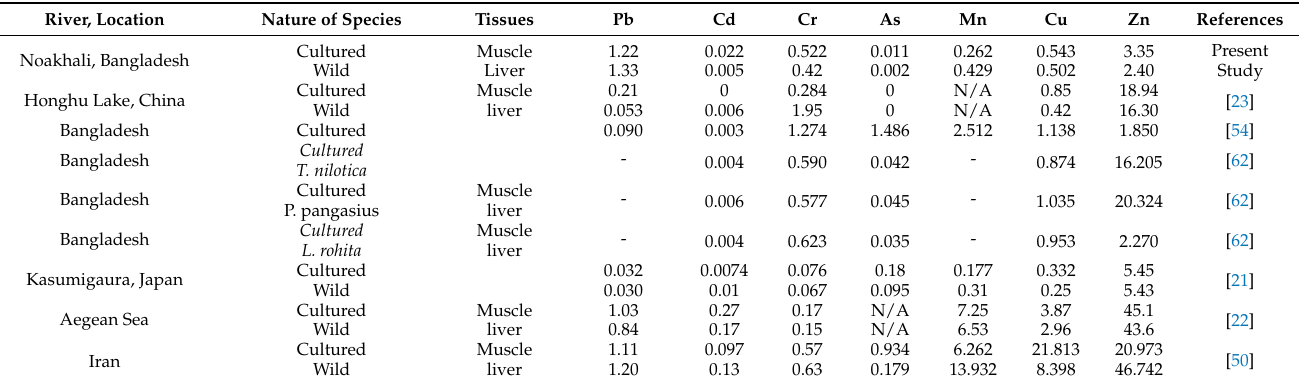
Table 3. Concentration of the metals (mg/kg wet weight) in the fish sample muscles of cultured and wild Barramundi in different global studies.